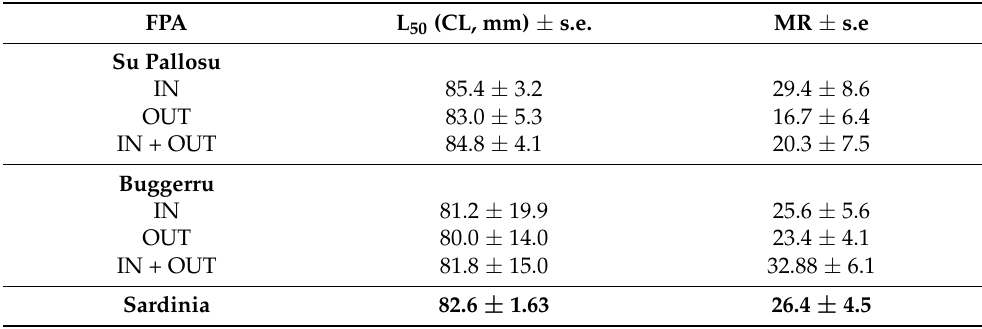
Table 3 . Size at functional maturity (L 50 ), Maturity Range (MR), standard error (s.e.) are reported for Su Pallosu and Buggerru FPAs, inside (IN) and outside (OUT) and for the two areas combined together (Sardinia).